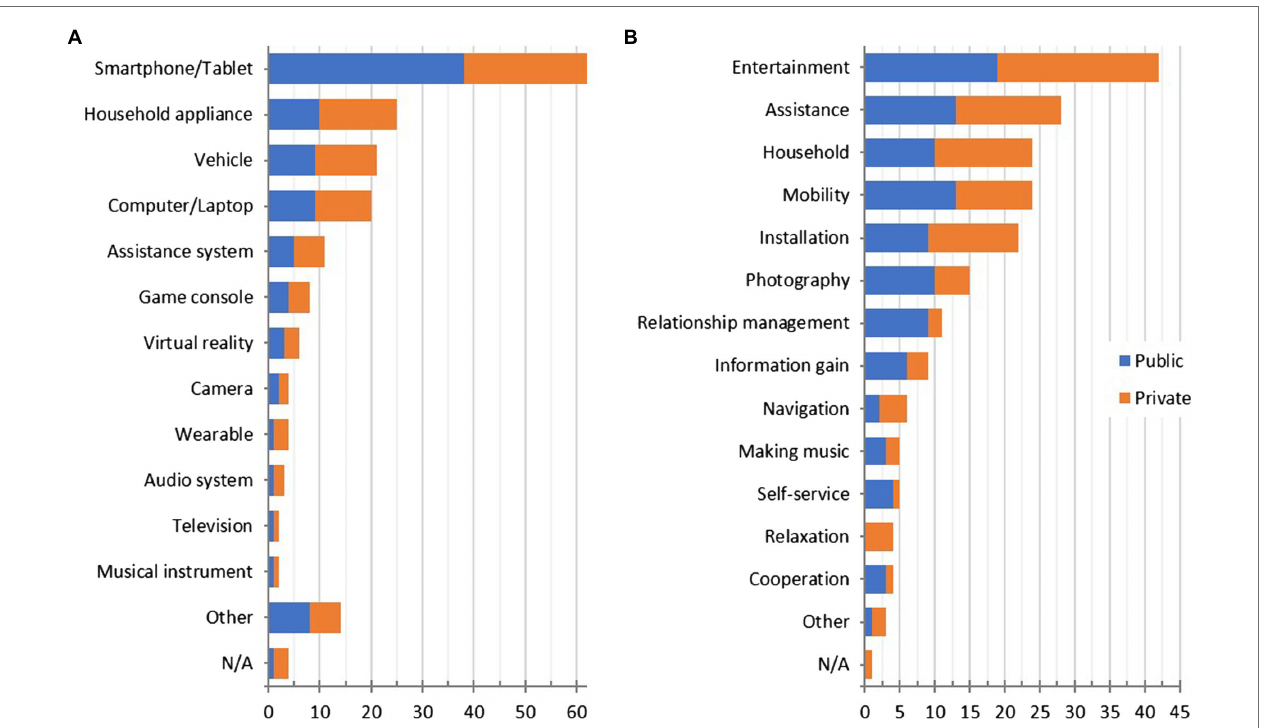
FIGURE 2 | Categorization of recalled experiences in public and private context by (A) product types and (B) function of interactions. Absolute frequency of all categories in total